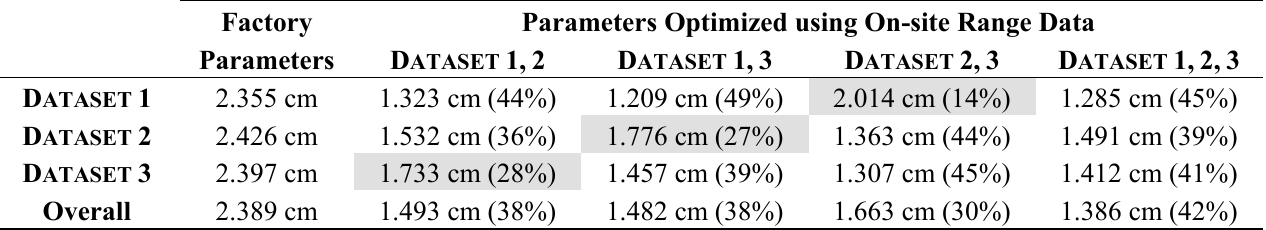
Table 2. RMS Errors and Improvement After